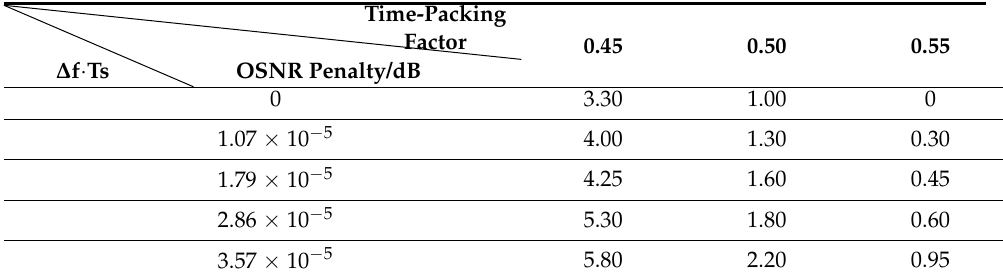
Table 2. The OSNR penalty for the modified-BPS algorithm under 0, 1.07 × 10 − 5 , 1.79 × 10 − 5 , 2.86 × 10 − 5 and 3.57 × 10 − 5 ∆ f · Ts with the time-packing factor of 0.45~0.55.